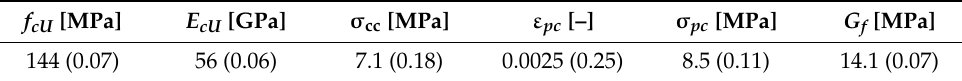
Figure 3. Results of flexural tests for characterization of HPFRC. Table 1. Material properties of HPFRC at testing age: average (coefficient of variation) (Refer to Figure 2 for the meaning of symbols).